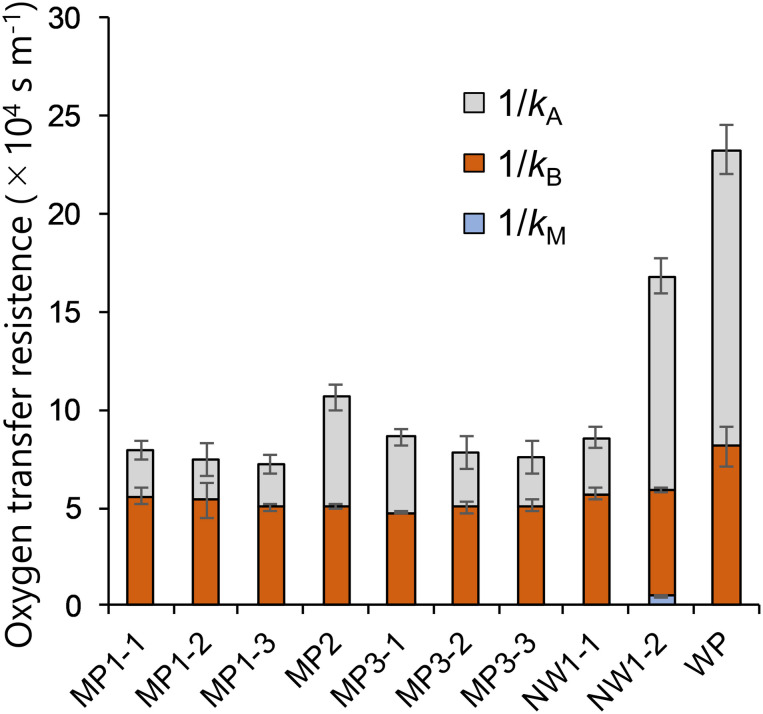
Breakdown of mass transfer resistance in the Water–Water oxygen permeation test. N = 3 for all membranes. Error bars show the standard deviation of each breakdown.